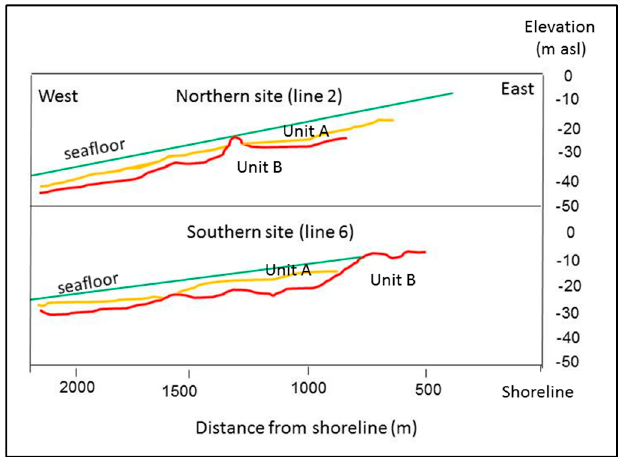
Figure 8. Interpretation of CHIRP lines 6 and 2 (location in Figure 8). The top Kurkar layer is shown by red line, the top clay layer by orange line and the seabed by green line.